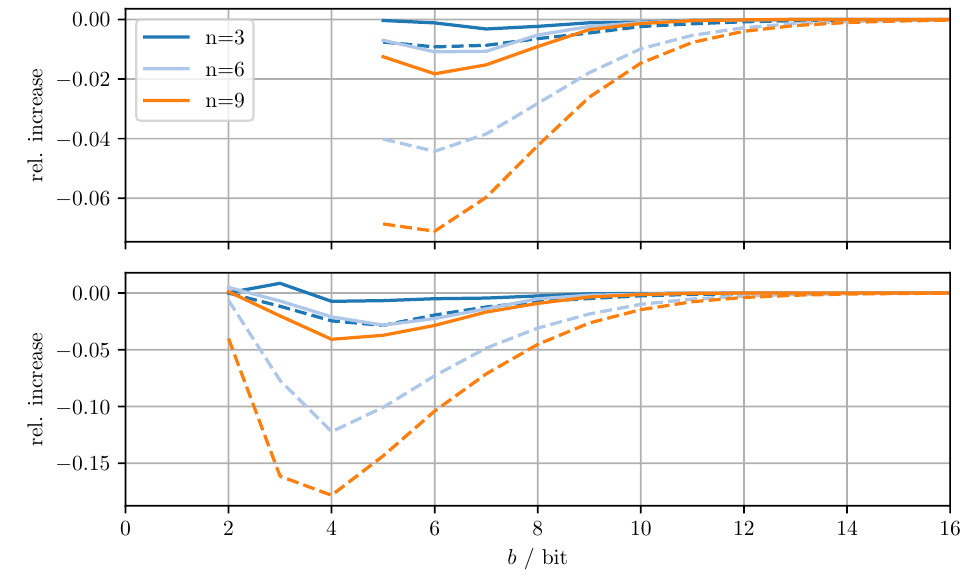
Figure 5. Relative increase of actual MSE (solid)/averaged trace (dashed) of MC-OPT with respect to DD-OPT for varying dimensions n and bits per codeword b . Top row with quantized estimate vector and quantized error covariance, bottom row only with quantized error